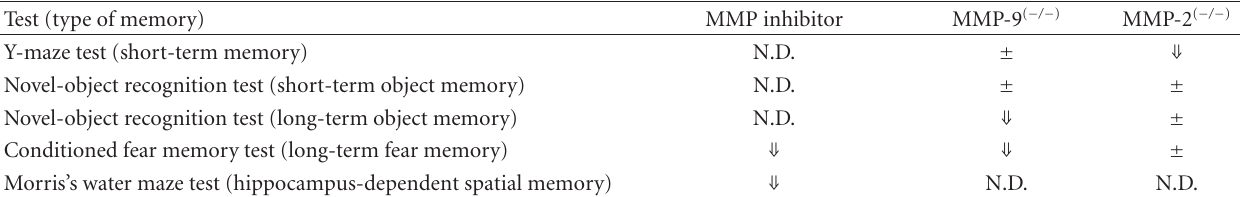
Table 2: Summary of impaired learning and memory parameters induced by MMP inhibition.